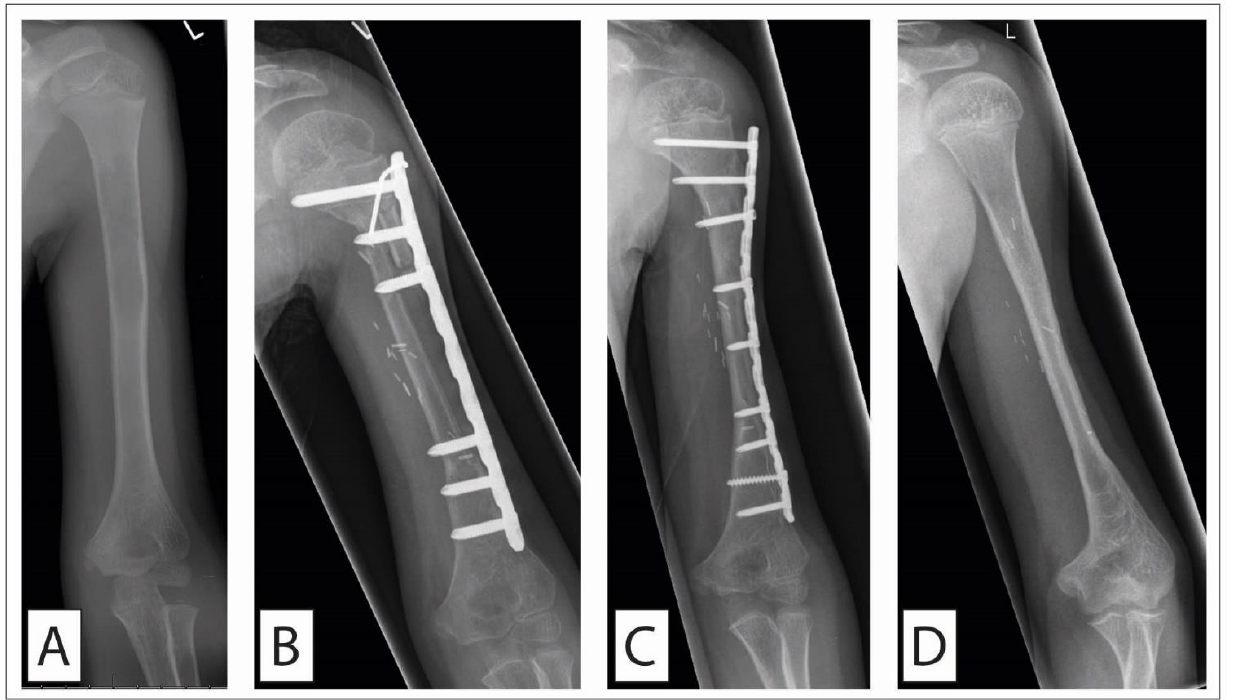
Figure 3. Ewing sarcoma of the humerus treated with a vascularized fibula graft. A 6-year old boy presented in the ward with persisting pain for 2 months in the left upper arm accompanied by intermittent fever. The plain a-p radiograph shows the central osteolysis within the diaphysis ( A ). Open biopsy was performed, showing Ewing sarcoma. After neoadjuvant chemotherapy, we performed complete en bloc resection (R0). The defect was reconstructed using a vascularized fibula graft by our colleagues from the department of plastic surgery ( B ). Temporary stabilization was performed with an LC-DCP plating. Seven months postoperatively, the fibula appeared radiologically fully osseointegrated distally, but a non-union with fracture of the plate was present proximally between the second and third screw. The LC-DCP was removed, and a titan elastic nail inserted. Postoperative care was a total cast of the left arm. Three months postoperatively, autologous bone from the iliac crest was placed at the non-union site followed by again plating of the humerus ( C ). ( E ) One year thereafter, the osteosynthesis material could be completely removed. The patient could freely use his arm, with, in the plain a-p radiograph, only a slimmer silhouette of the diaphysis still reminding of the performed procedure. Even when using a vascularized bone, as in the present case, bone healing can be challenging due to the immediate continuation of chemotherapy after wound healing.